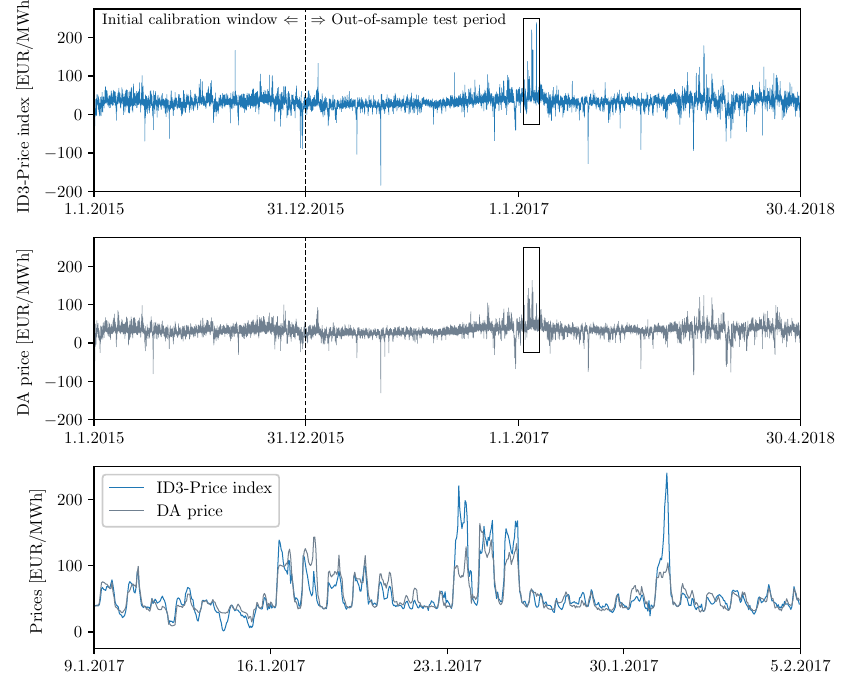
Figure 1. The ID3-Price index ID3 d , h ( top ) and the day-ahead prices DA d , h ( middle ) from 1 January 2015 to 30 April 2018, and a zoom in on a 4-week period of both price series ( bottom ). The vertical dashed lines mark the beginning of the 852-day long out-of-sample test period and the boxes show the zoom in area.